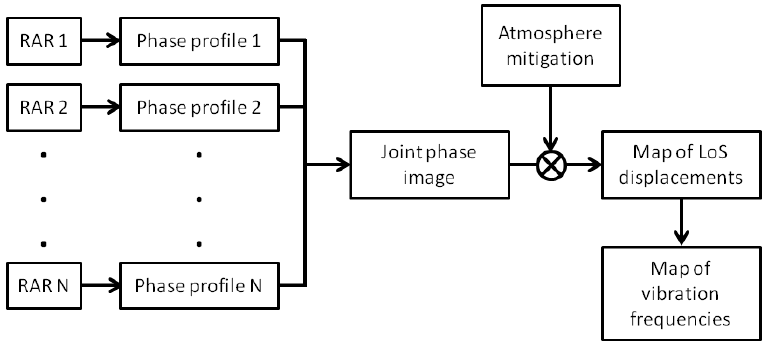
Figure 4. Sketch of the proposed methodology for the processing of ground-based SAR data: ( a ) geolocation, correction for the LoS factor and 3D rendering of displacement measurement; ( b ) merging of displacement measurement for the estimation of the geolocation displacement vectors.